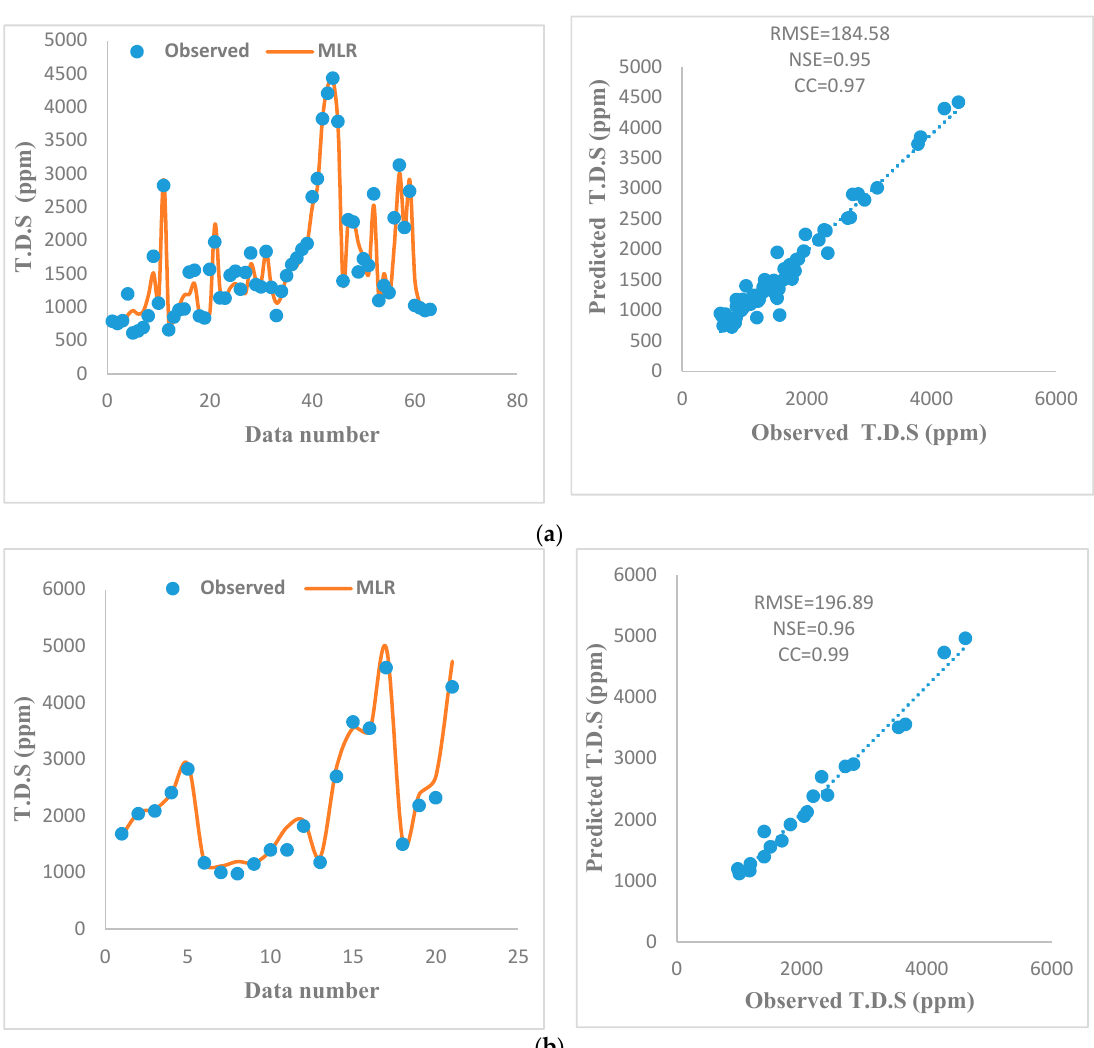
Figure 9. Comparative plots of observed and predicted TDS values using MLR model for ( a ) calibration data set and ( b ) validation.